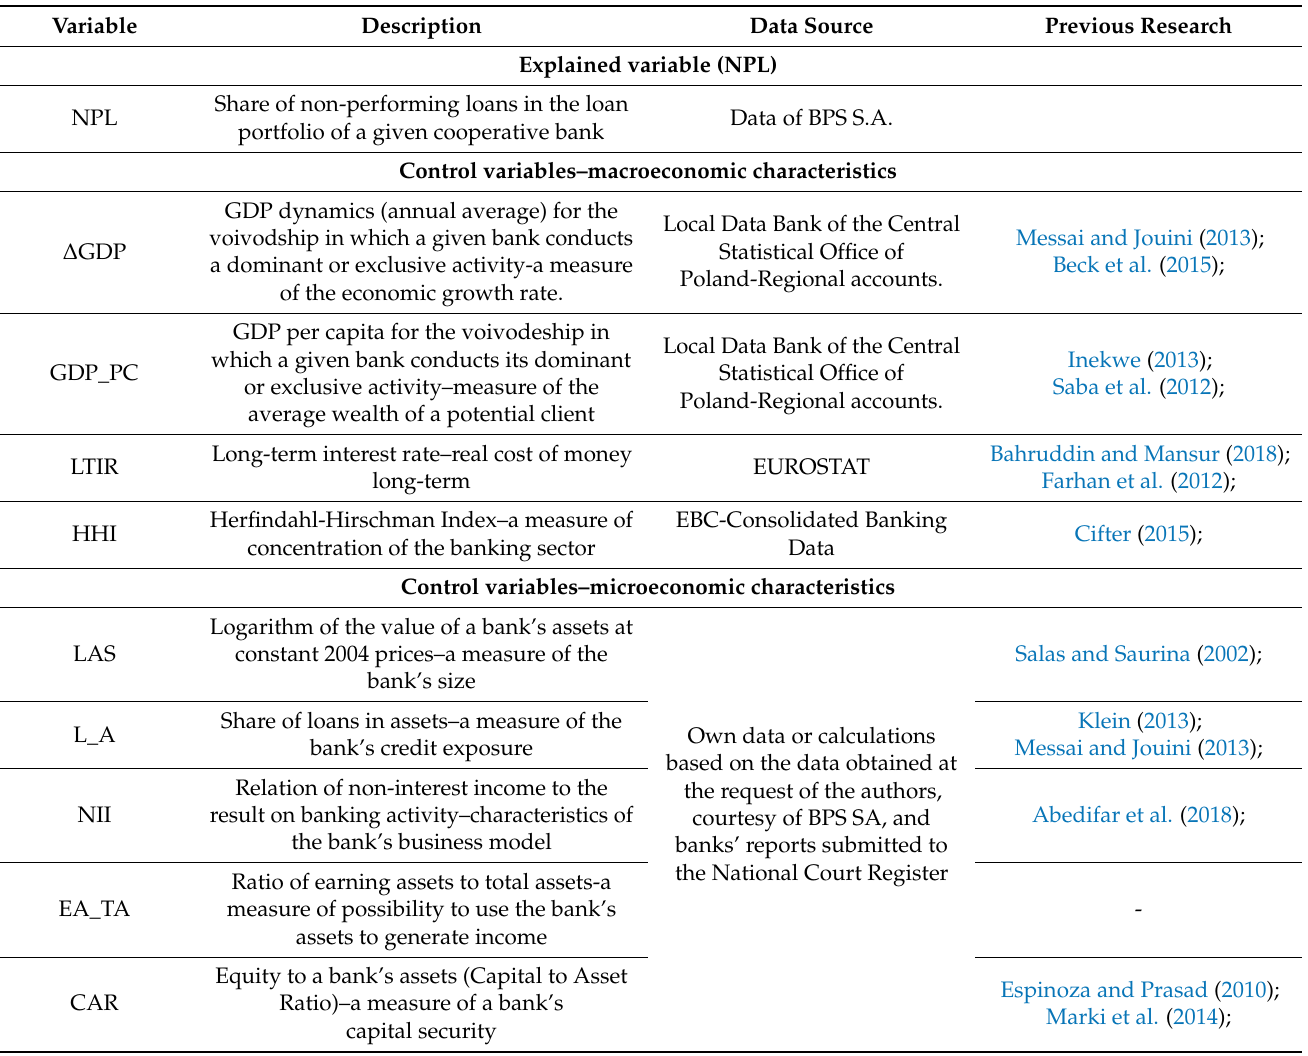
Table 2. Characteristics of variables used for panel studies of the quality of the loan portfolio of cooperative banks of the BPS S.A. association in the years